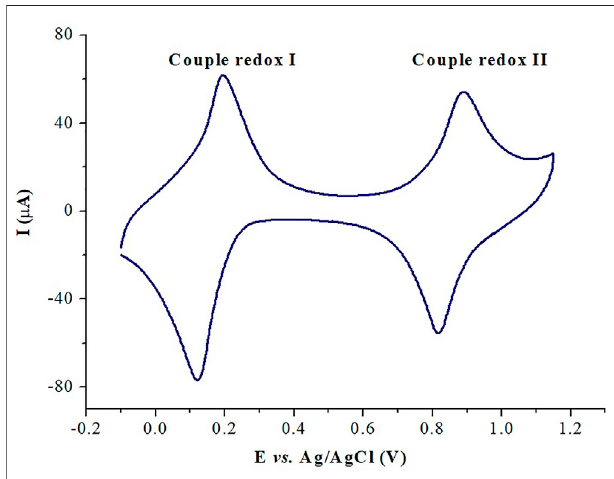
FIGURE 8 | Cyclic voltammetry of PB-fCNT/TiO 2 .ZrO 2 (36)500 ° C.20/ GC-modi fi ed electrodes in PBS, pH 3.0 at 40 mVs -1